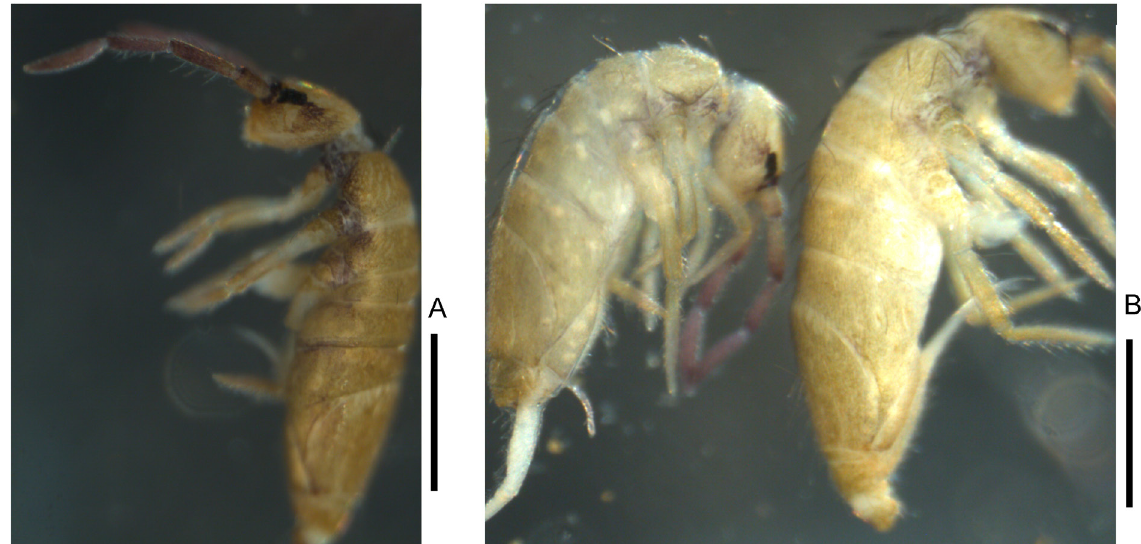
Fig. 11. Entomobrya dingi sp. nov. A–B . Habitus. Scales bar: A–B = 500 μm.